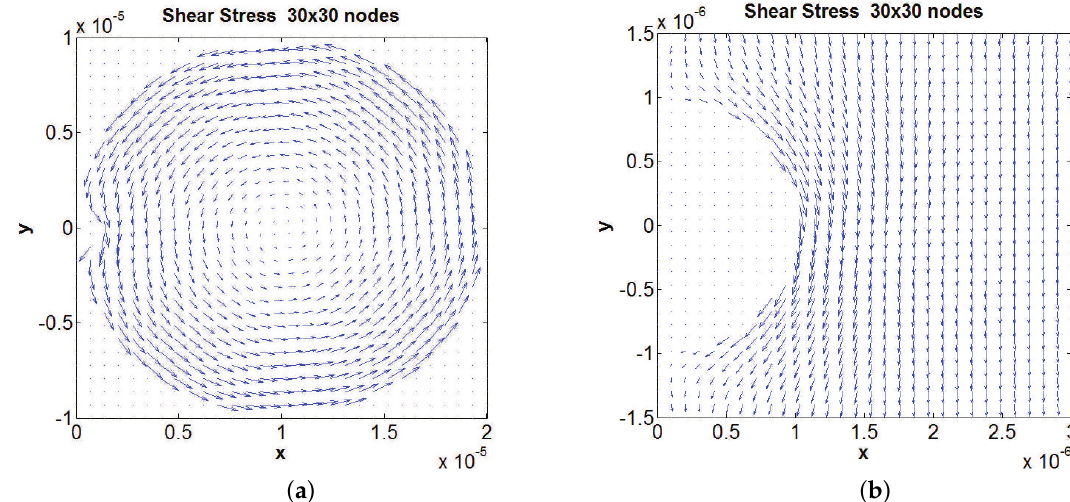
Figure 8. Shear stress vector field with the analytical approach in a: ( a ) 20 µ m × 20 µ m grid; and ( b ) 3 µ m × 3 µ m grid.